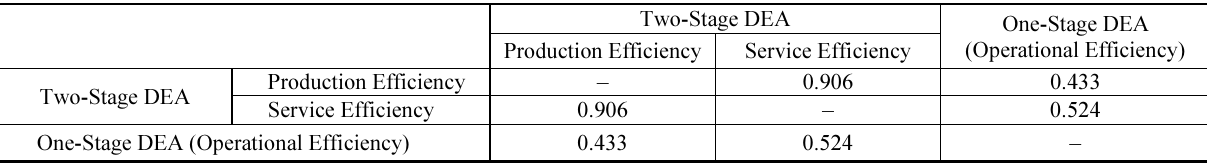
Table 8. The Wilcoxon sign-rank test